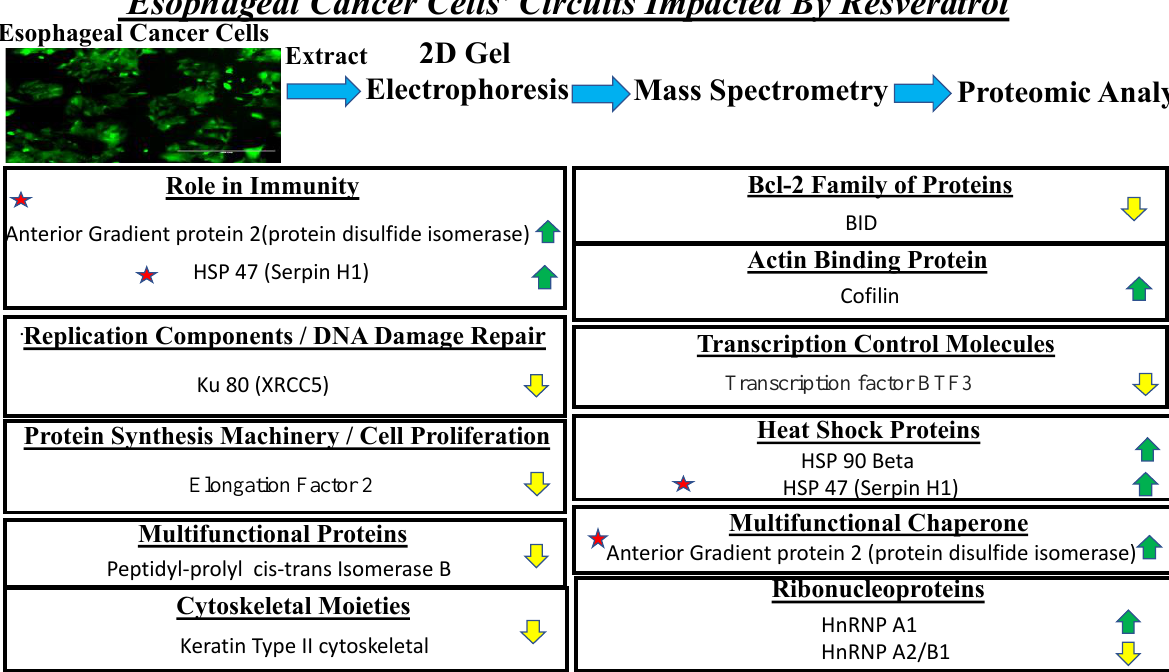
Figure 7. Schematic representation of pivotal circuits deregulated in the three esophageal adenocarcinoma cell lines (OE33, OE19 and FLO-1). Upregulated molecules are indicated by green arrow. Downregulated molecules are indcated by yellow arrow. Star represents the additional role of the identified entities in